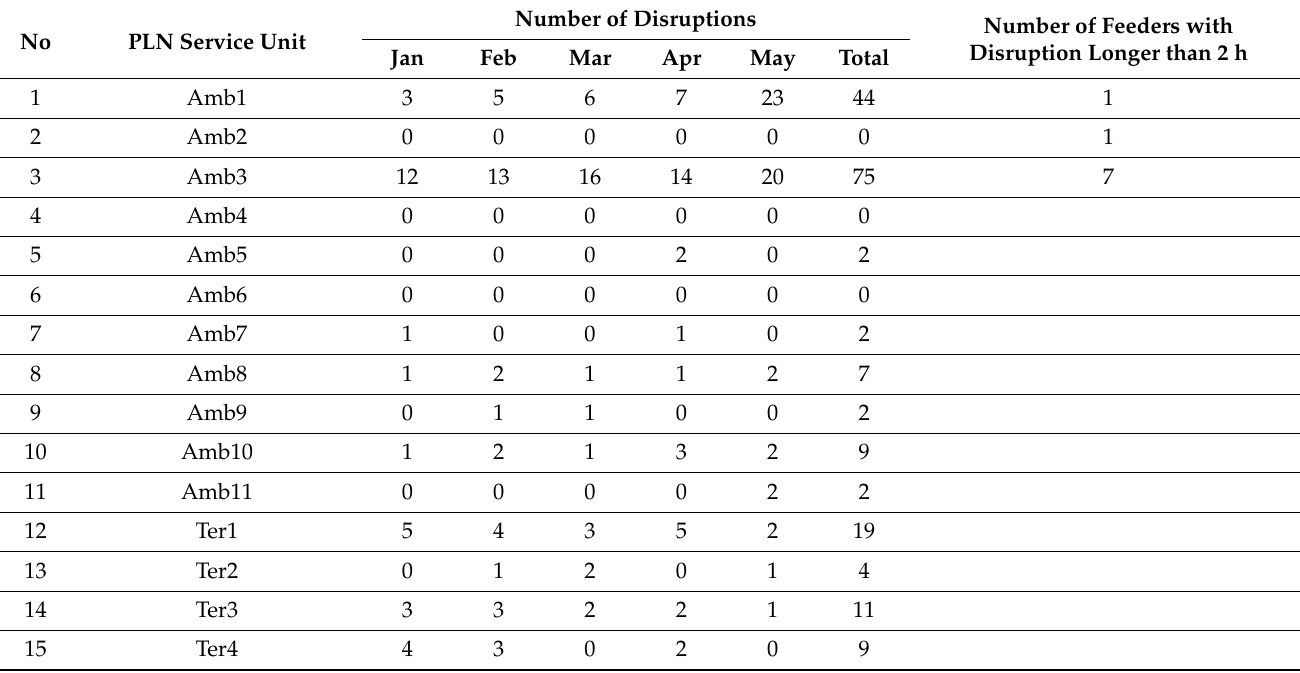
Table A4. Maluku and North Maluku feeder disruption report in 2021. Total feeders: 203. (PLN